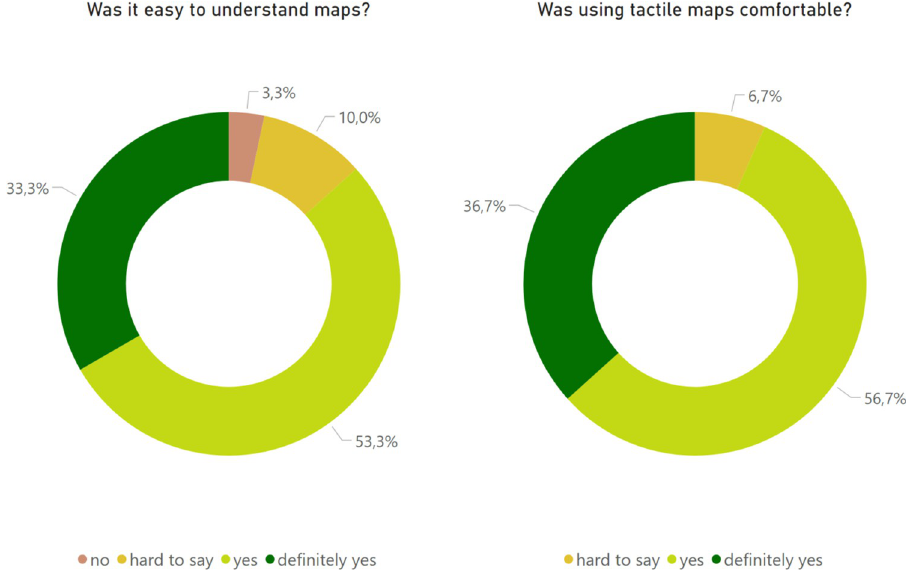
Fig 9. Results of the post-study